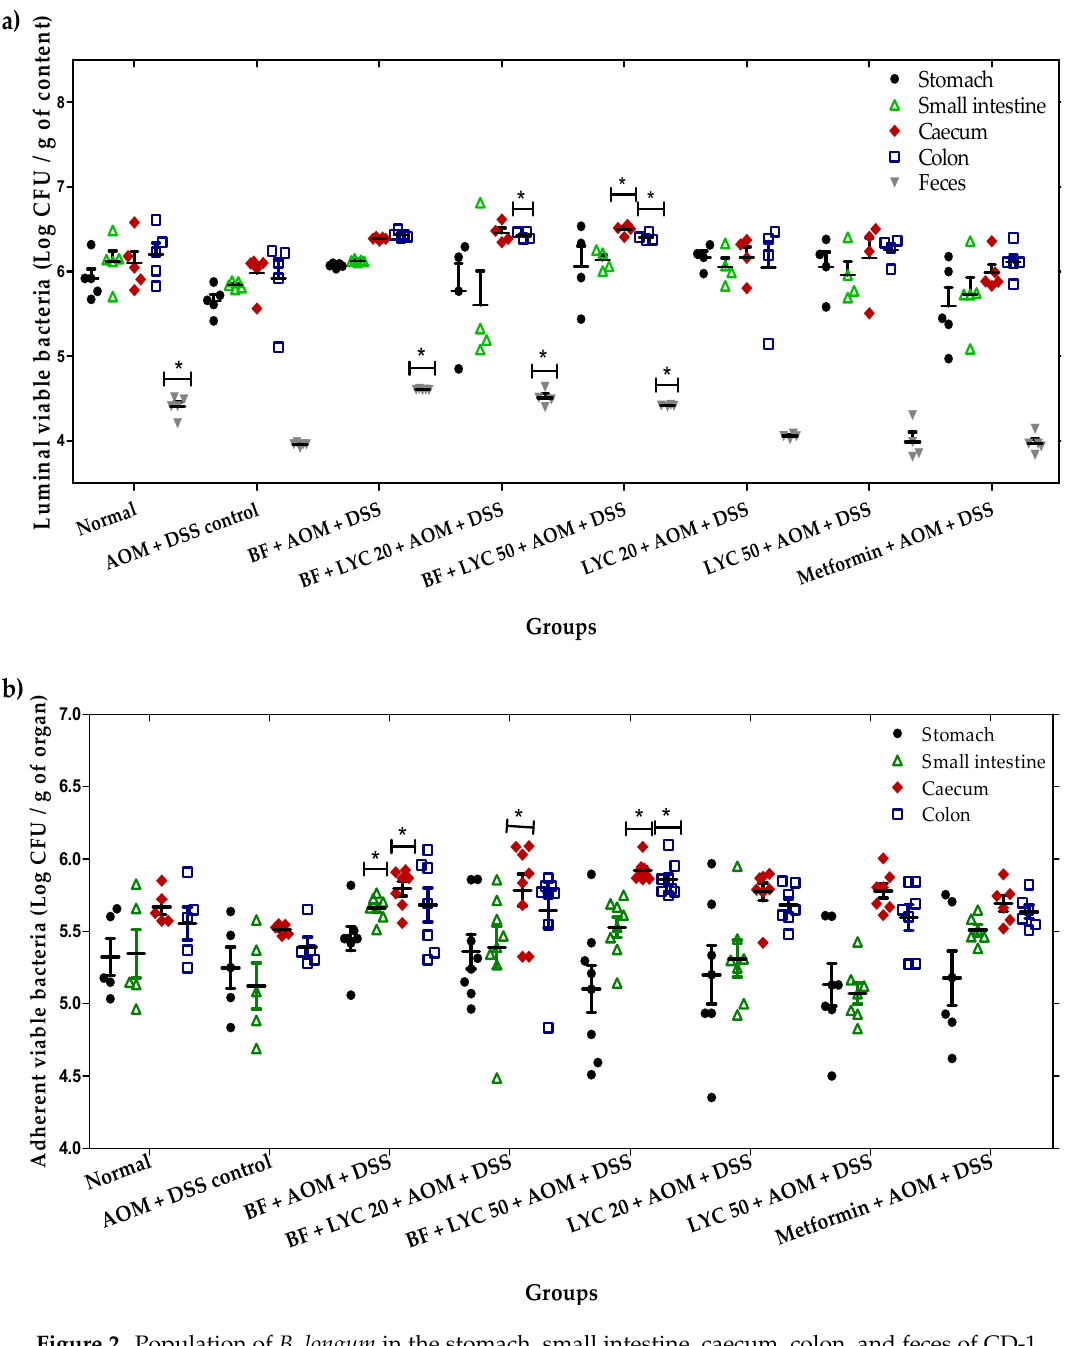
Figure 2. Population of B. longum in the stomach, small intestine, caecum, colon, and feces of CD-1 mice at week 16 of the treatment. Values are Log CFU/g of content in the luminal content, feces ( a ) or adherent to the tissue ( b ) at different gastrointestinal sections, as indicated. The asterisks (*) indicate significant differences compared to the AOM + DSS control group (Dunnett α = 0.050). Each bar represents the mean ± SEM ( n = 6–10 animals per group).